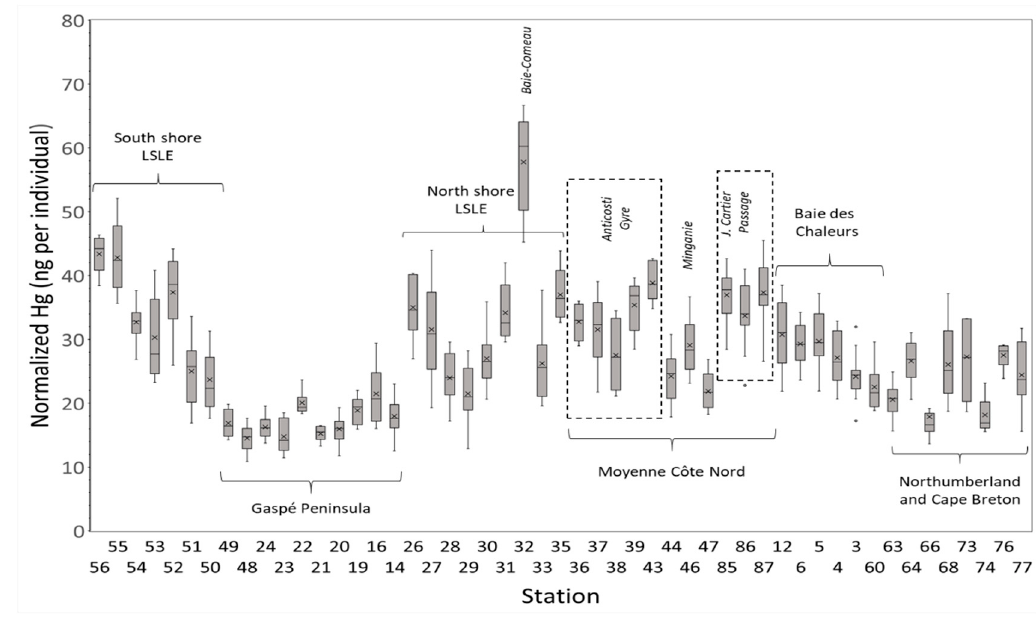
Figure 3. Mercury content (ng) of individual mussels after normalization to 35 mm-long and 0.17 g virtual specimens. Mean contents are indicated by a horizontal bar and the median by a cross. Each station combines 10 to 12 individual mussels. Stations are eastward distributed on the x-axis.